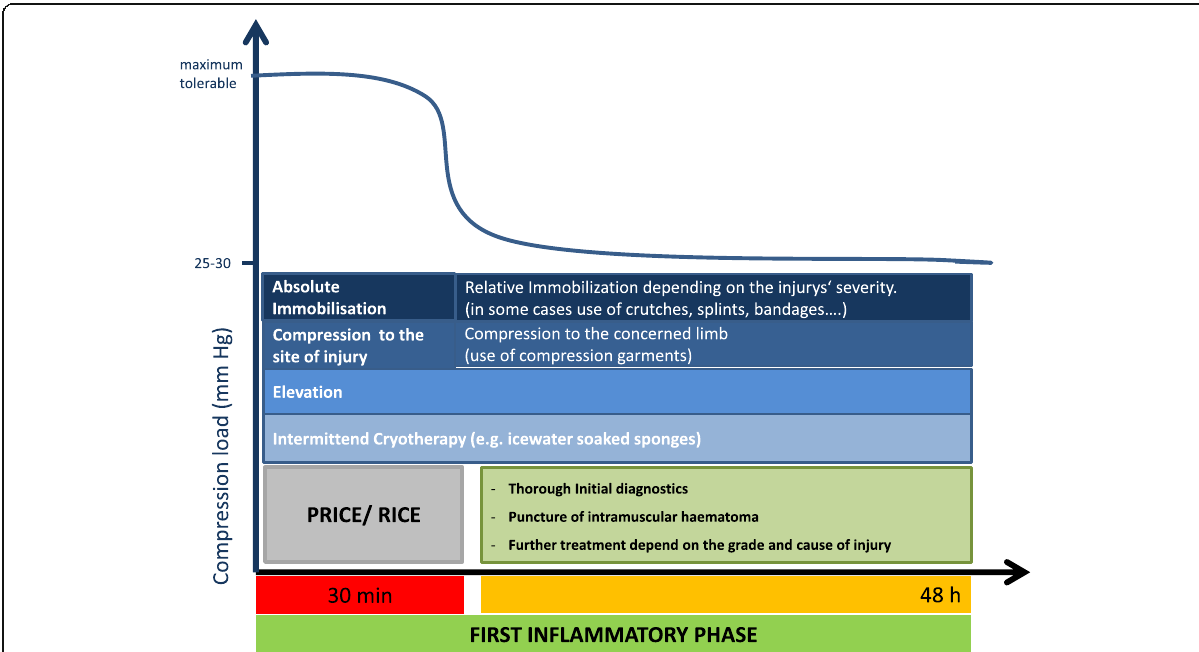
Fig. 3 Illustration of the treatment algorithm for the initial therapy during the first inflammatory phase (0 – 48 h after the injury event)